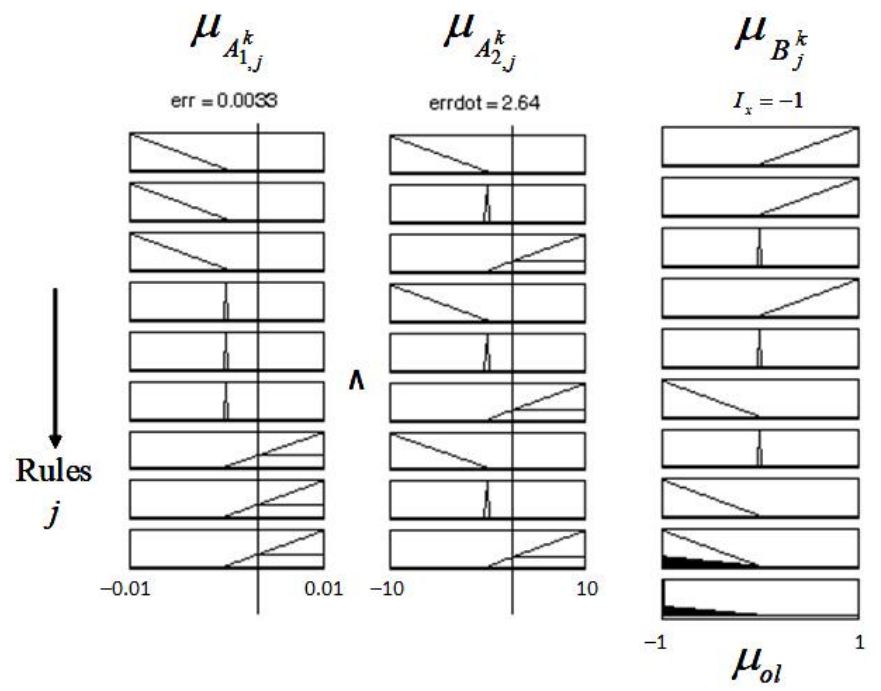
Figure 5. Fuzzy rules aggregation and defuzzification view.